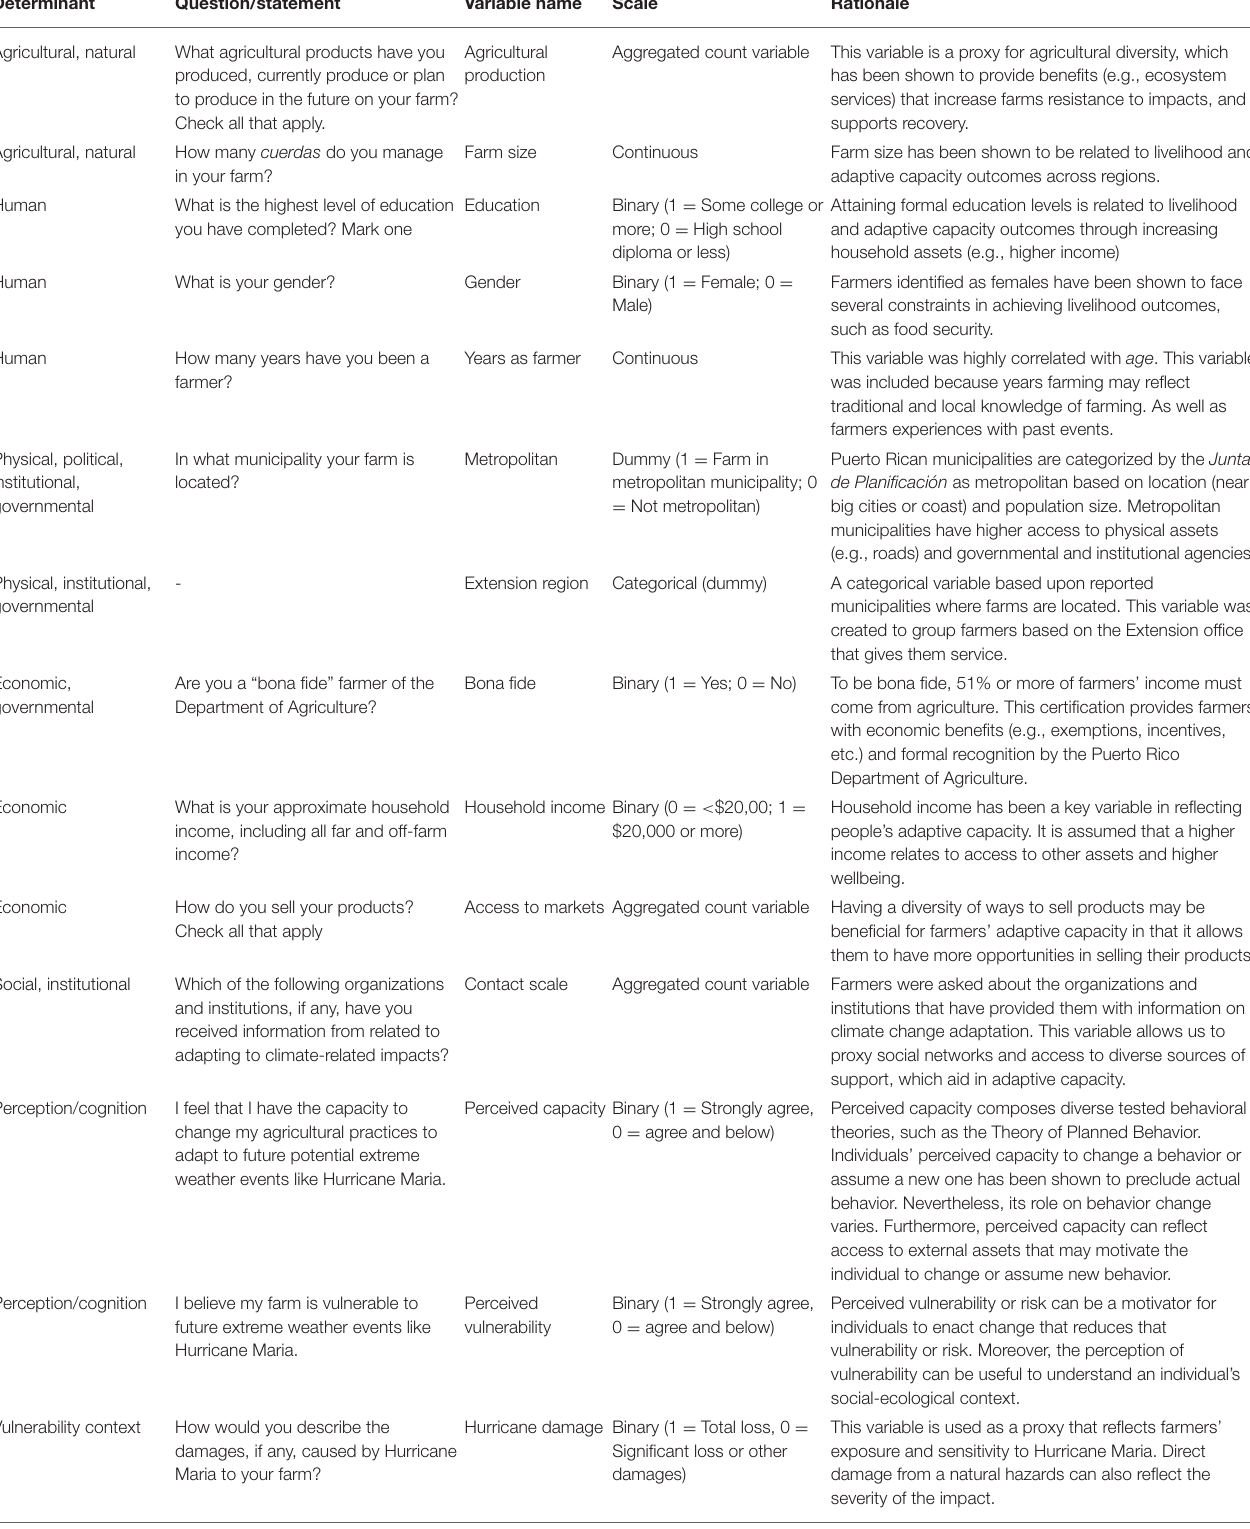
TABLE 2 | Independent variables used in quantitative